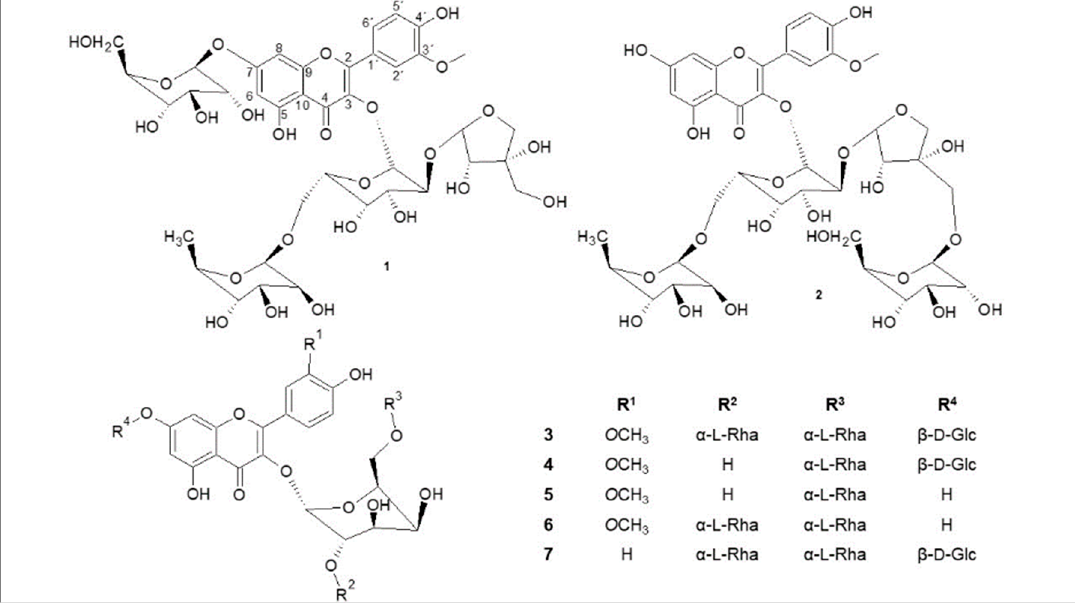
Figure 3. Structures of isolated compounds 1 – 7 .